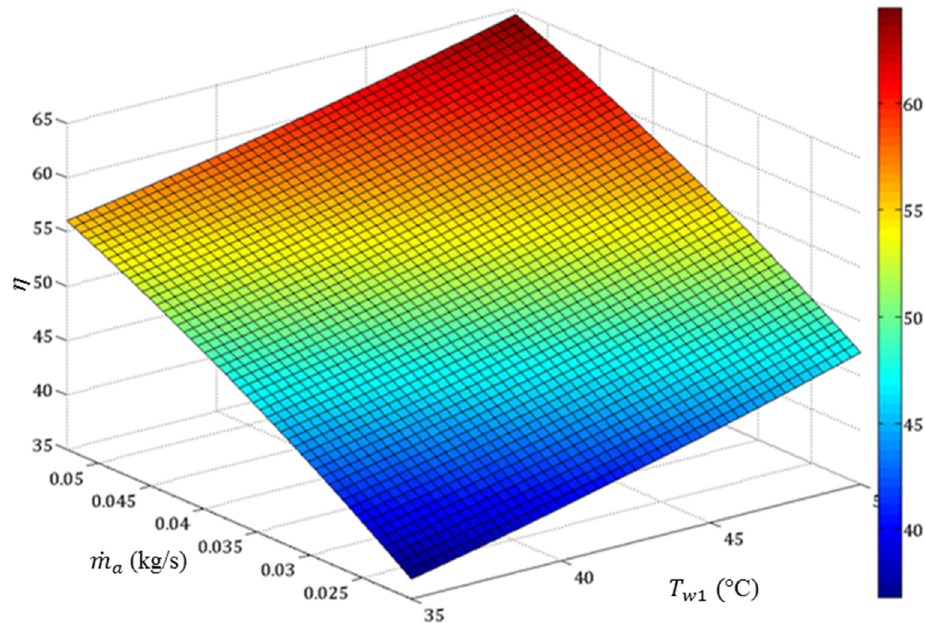
Figure 8. Cooling tower efficiency based on inlet water temperature and air flow rate.